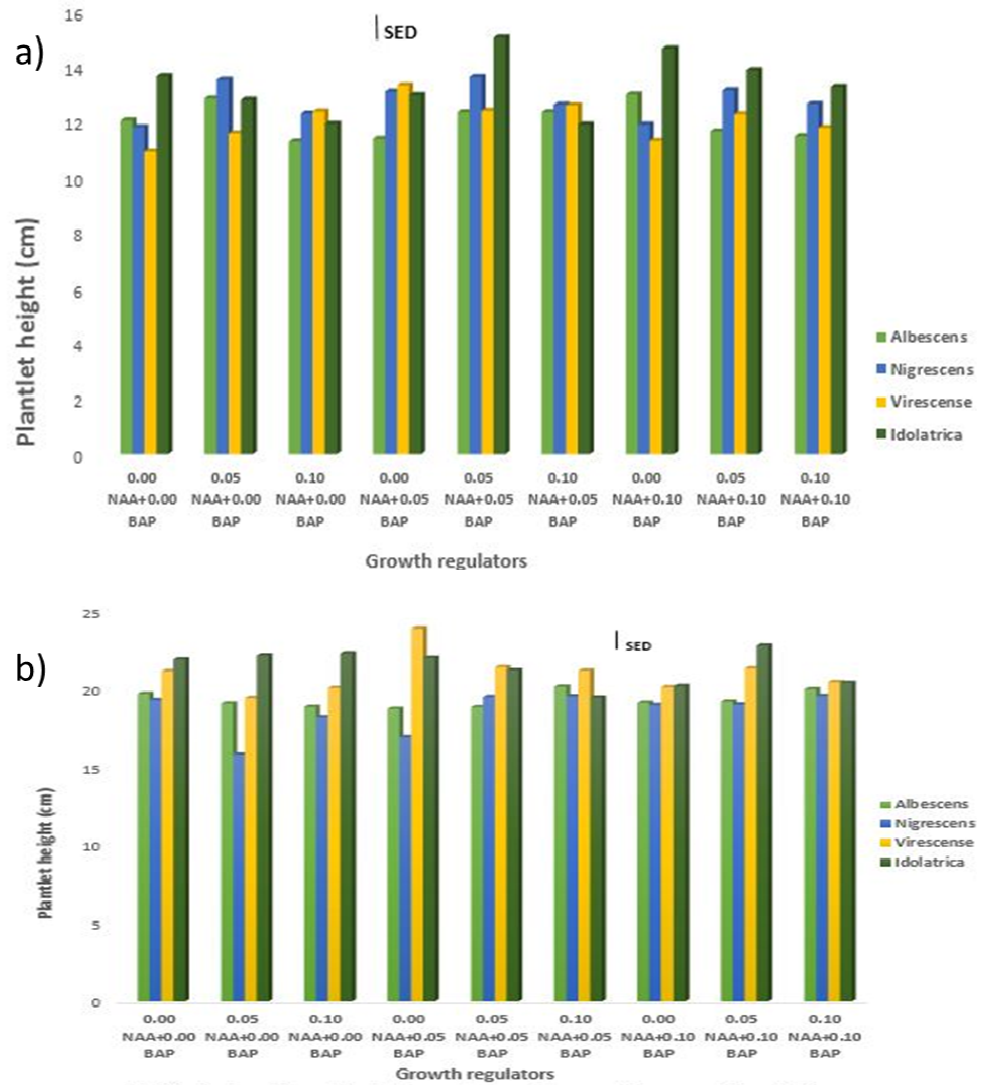
Fig. 2a. Interaction effect of growth regulators and type-variety of oil palm on plantlet height at 56 days after culture initiation Fig. 2b. Interaction effect of growth regulators and type-variety of oil palm on plantlet height at 84 days after culture